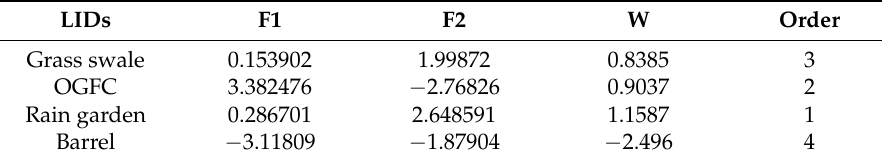
Table 10. LIDs evaluation index and rank for LCTIP.